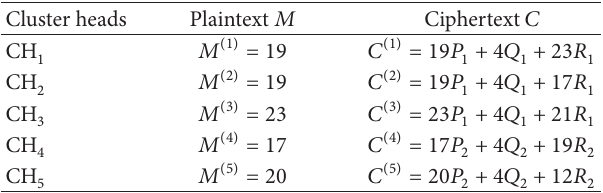
Table 5: The encryption in intercluster data aggregation.